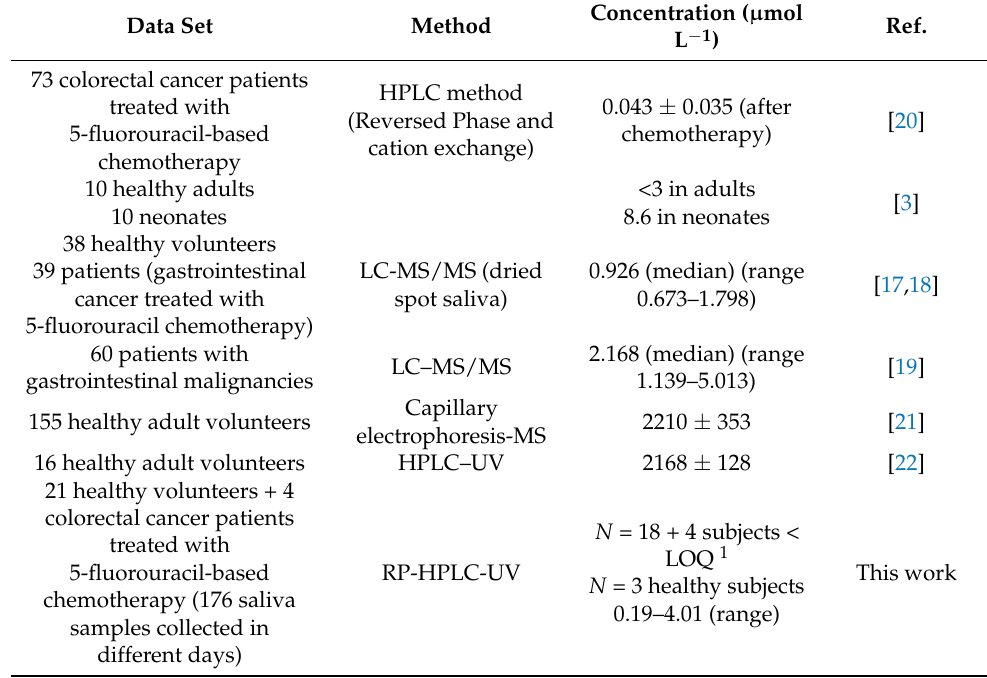
Table 2. Summary of data on DHU quantitation in